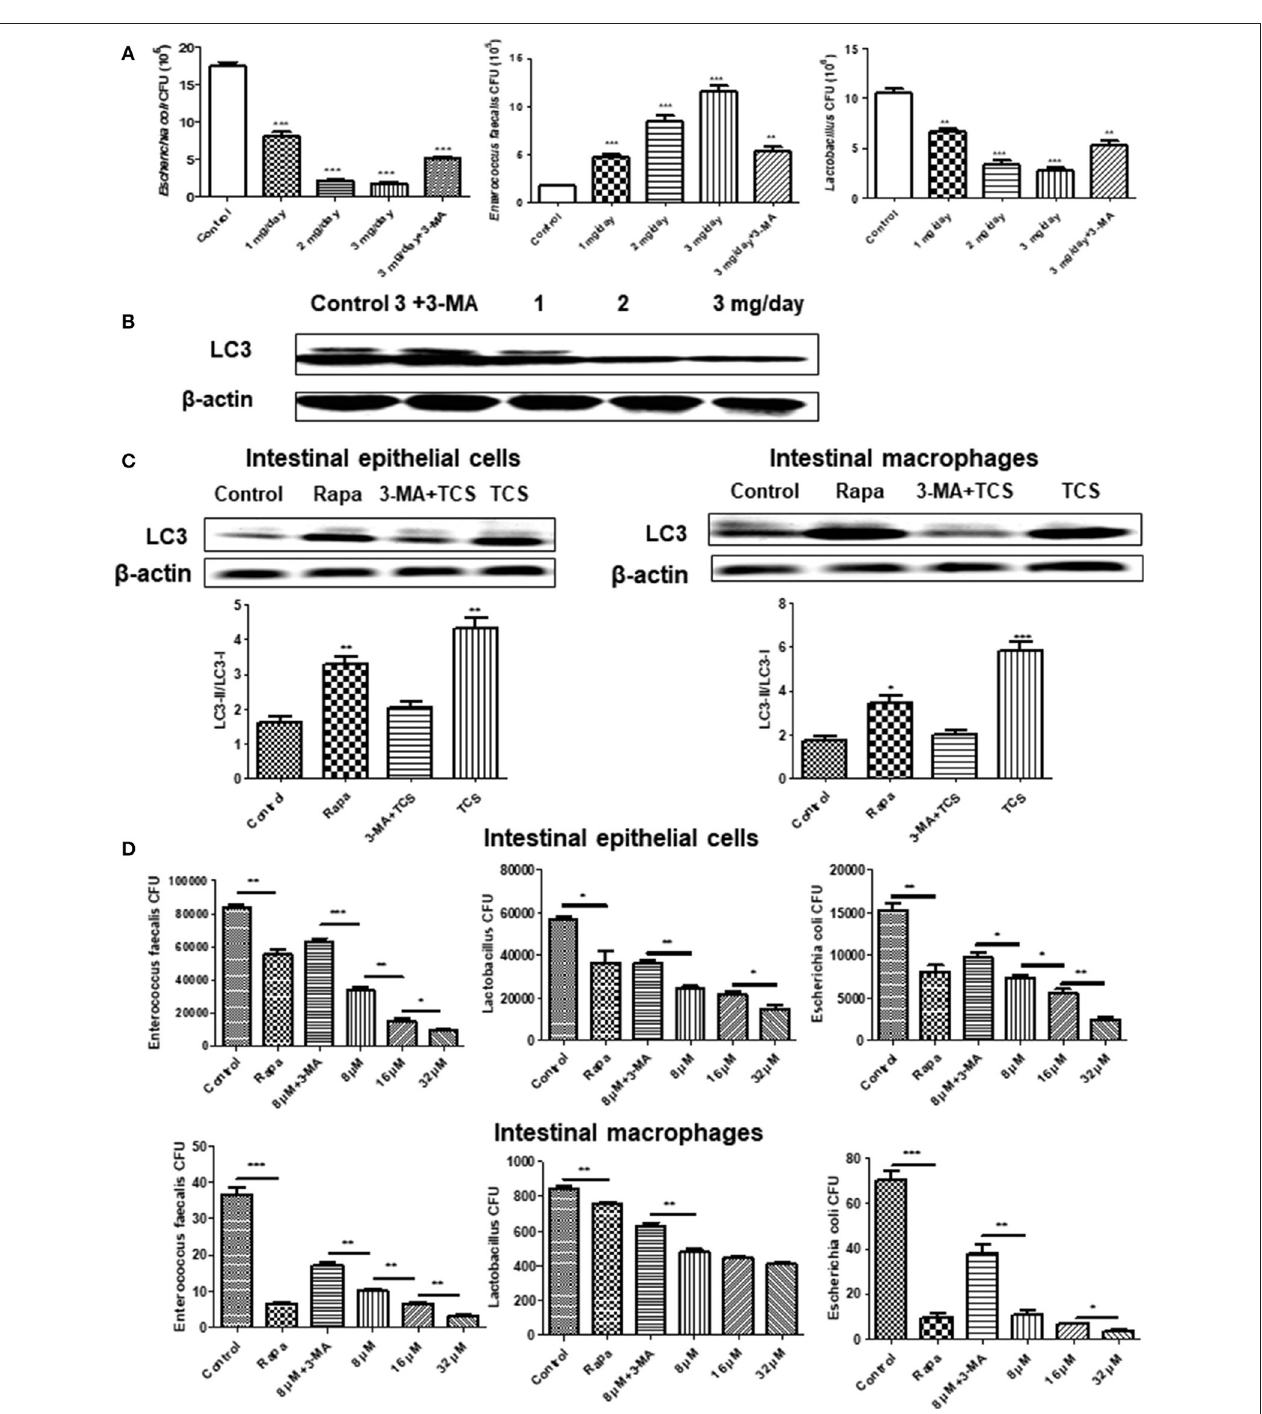
FIGURE 4 | The effects of long-term TCS administration on intestinal microbes in mice. Female BALB/c mice were treated with vehicle (0.5% methylcellulose − 0.1% Tween 80 in sterile water), TCS (1, 2, 3mg/day), or TCS (3mg/day) by oral ingestion of 15ml and with 20 µ l of 3-MA (24mg/kg) by an intraperitoneal injection for 30 days. Colony counting was used to calculate the major intestinal flora ( E. faecalis, Lactobacillus, and E. coli ) CFU (A) . A western blot was used to assay the expressions of LC3 in the mouse intestine (B) . A western blot was used to assay the expressions of LC3 in the extracted mouse intestinal epithelial cells and macrophages incubated with Rapa (200nM, 12h), TCS (8 µ M, 90min), or 3-MA (5mM, 180min) (C) . The extracted mouse intestinal epithelial cells and macrophages were incubated with Rapa (200nM, 12h), TCS (8 µ M, 90min), or 3-MA (5mM, 180min) first and were then infected with the major intestinal flora ( E. faecalis , Lactobacillus, and E. coli ) at an MOI of 25: 1. Colony counting was used to calculate the intracellular CFU (D) . Compared to the respective controls, * p < 0.05, ** p < 0.01, *** p < 0.001.